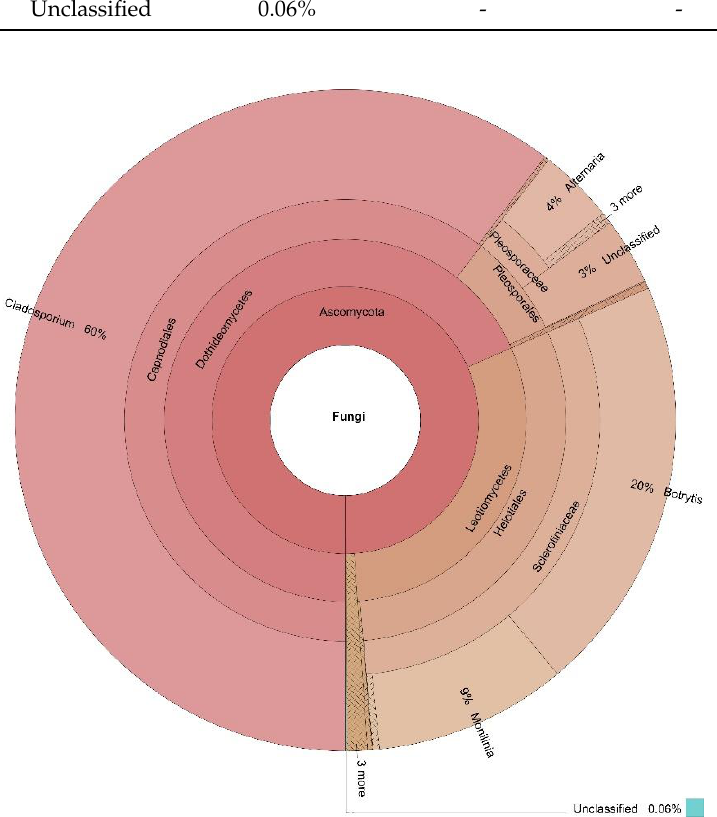
Figure 2. Krona display of the fungal composition of the samples from Dushantzi. All dominant genera accounted for more than 1% of the overall genera in the four locations. These belonged to the Ascomycota phylum, and are the focus of this study. They are listed in Table 4 while their incidence in the four locations is shown on the Venn diagram in Figure